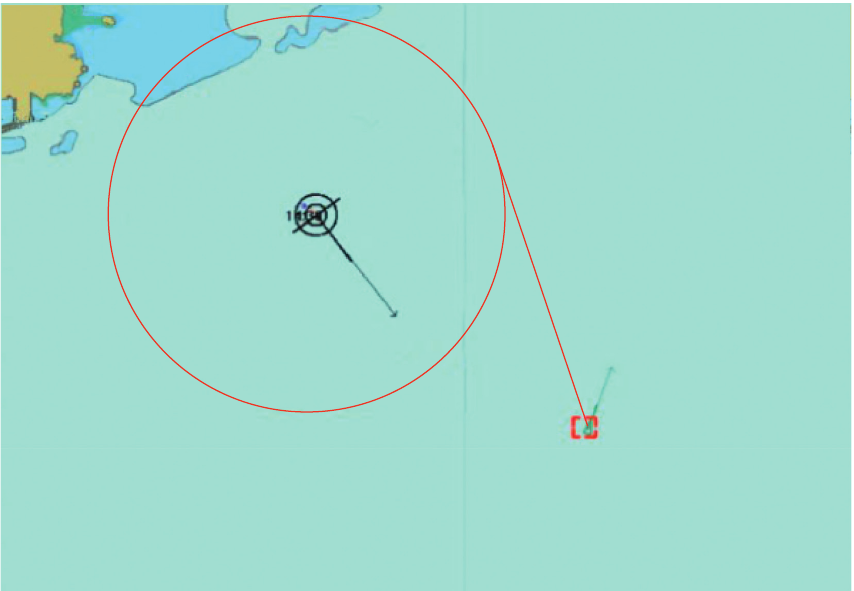
Figure 28: Right-steering collision avoidance.